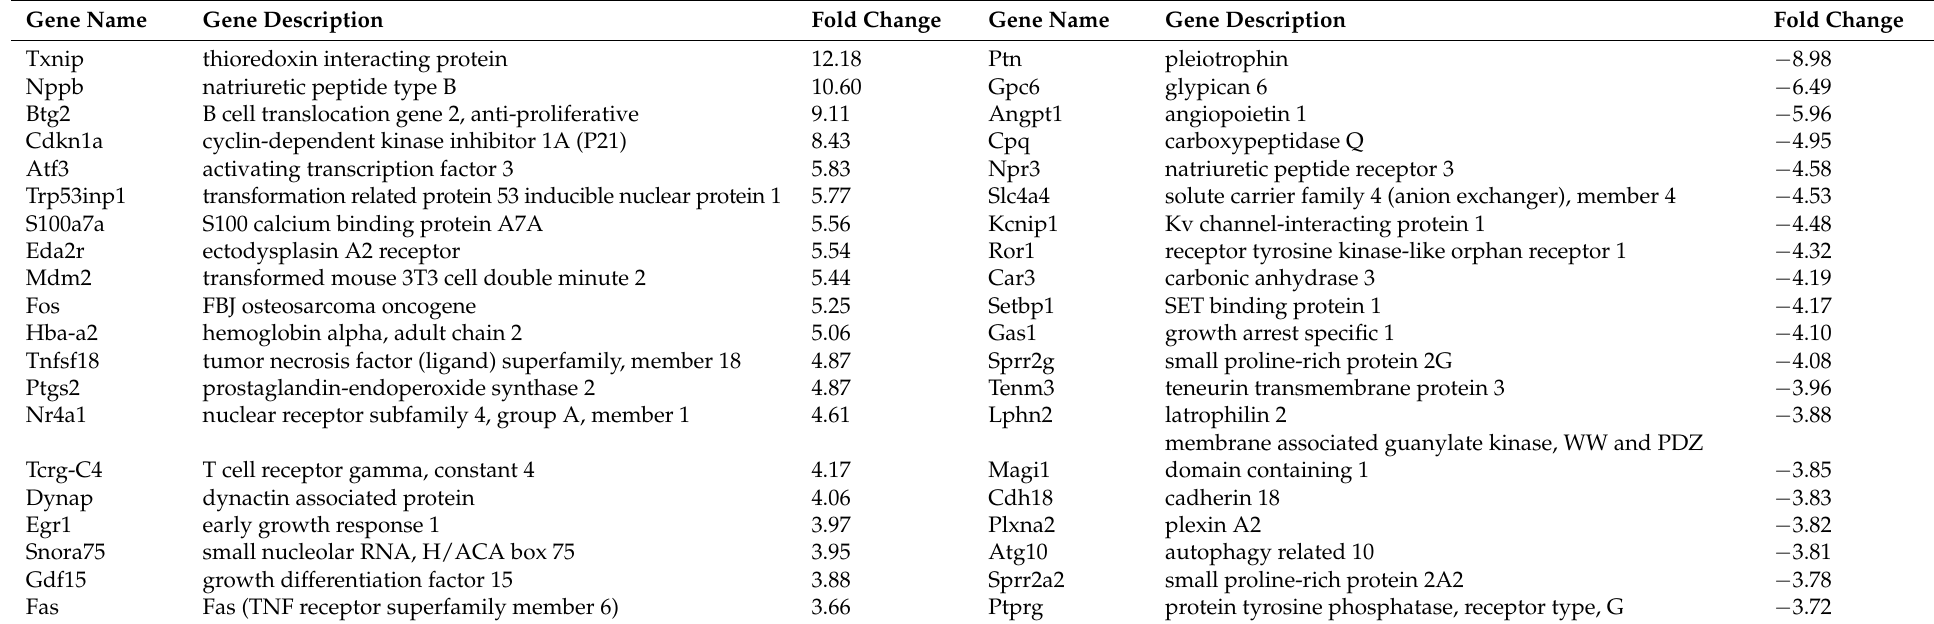
Table 5. List of top 20 up and downregulated genes in 48 h cisplatin